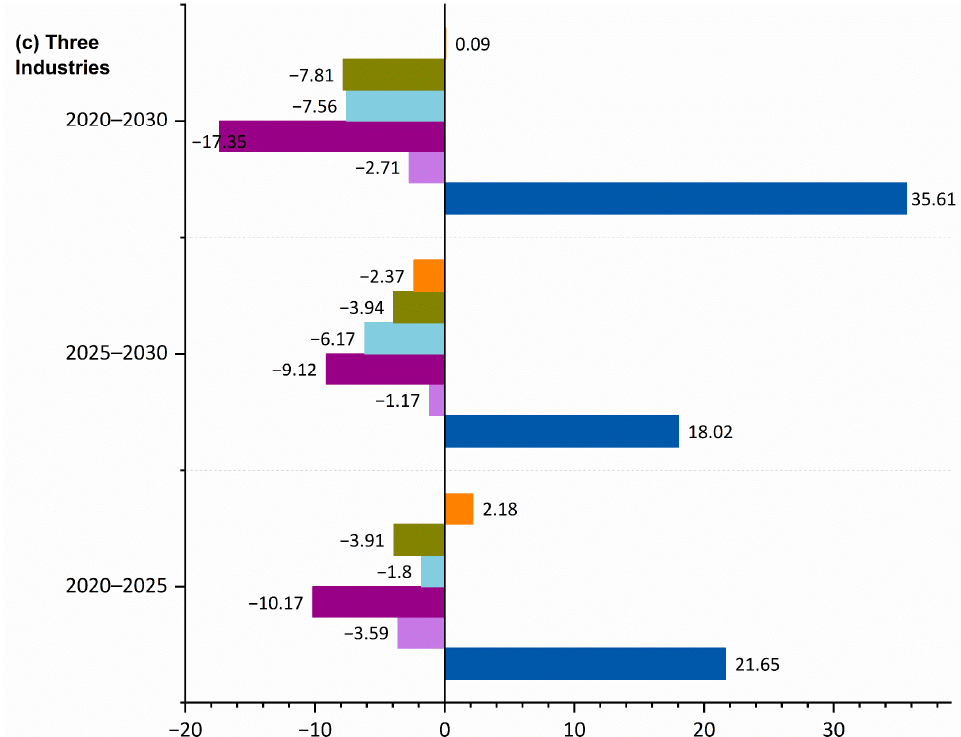
Figure 3. LMDI results in Shenzhen’s CO 2 emission from 2020 to 2030 (in the unit of MtCO 2 ). ( a ) LMDI results of secondary industry; ( b ) LMDI results of tertiary industry; ( c ) LMDI results of three industries.